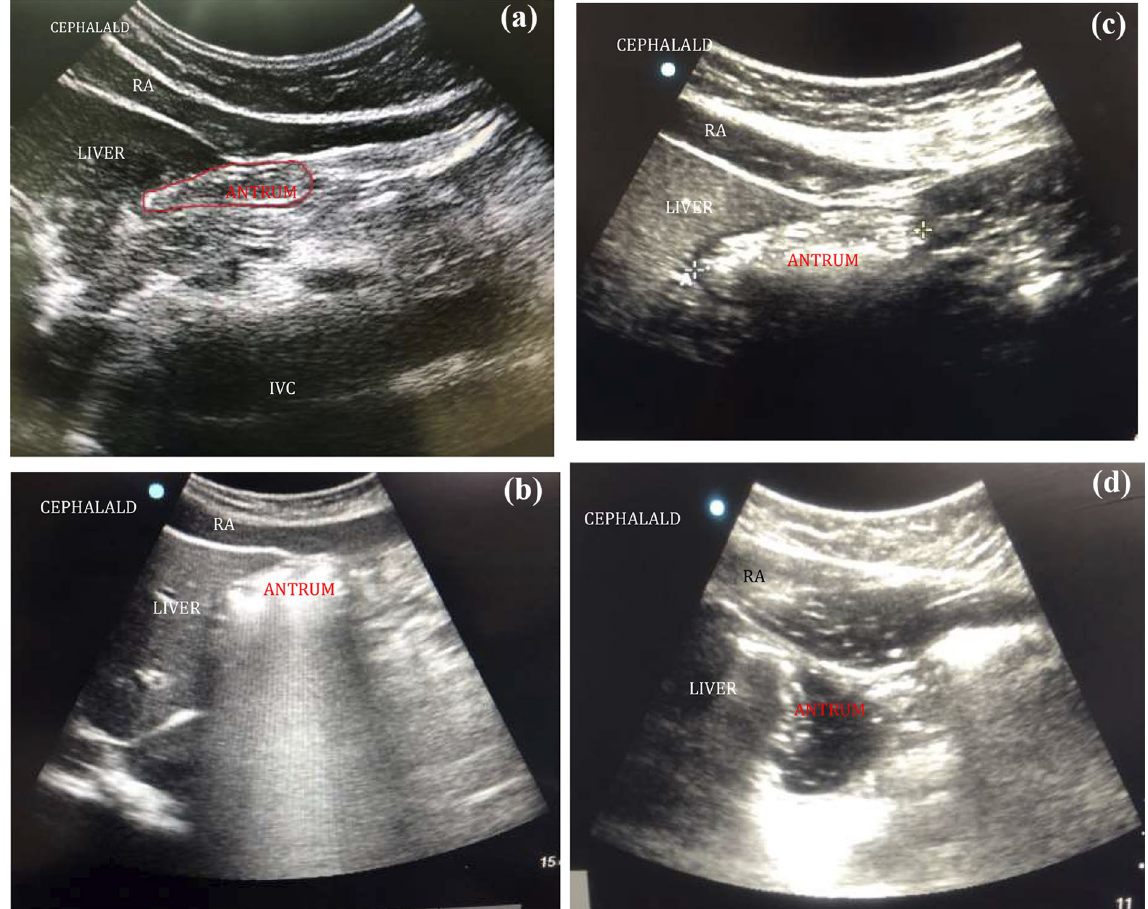
Fig. 2 a Sonoanatomy of empty gastric antrum. Antrum appears flat or bull’s eye shaped structure; RA (rectus abdominis), IVC (inferior vena cava). b Sonoanatomy of distended antrum. In early-stage, solids resembles ground glass appearance, the posterior wall of antrum is obscured; RA (rectus abdominis). c Sonoanatomy of distended antrum. In late-stage, solids appear heterogenous and hyperechoic (rectus abdominis). d Distended antrum with clear fluids and gas having/hypoechoic appearance (“starry night”)